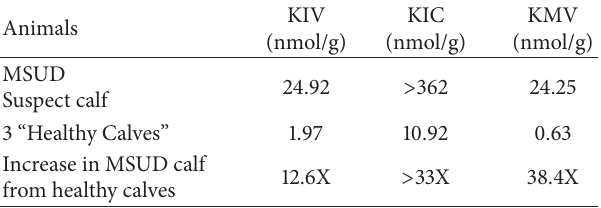
Table 1: Branched-chain ketoacid concentrations.